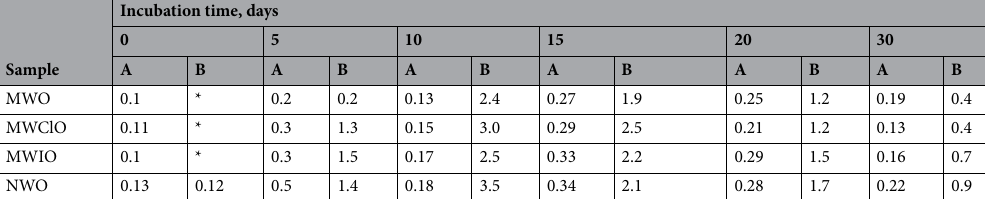
Table 3. Polysaccharide (A) (mg/L) and protein (B) (mg/ml) concentrations in the model solutions during incubation. Polysaccharide determination was carried out by the phenol–sulfuric acid method according to Dubois 34 . Protein content was measured with the Folin phenol reagent according to Lowry 35 . *Below range 0.05 mg/l.